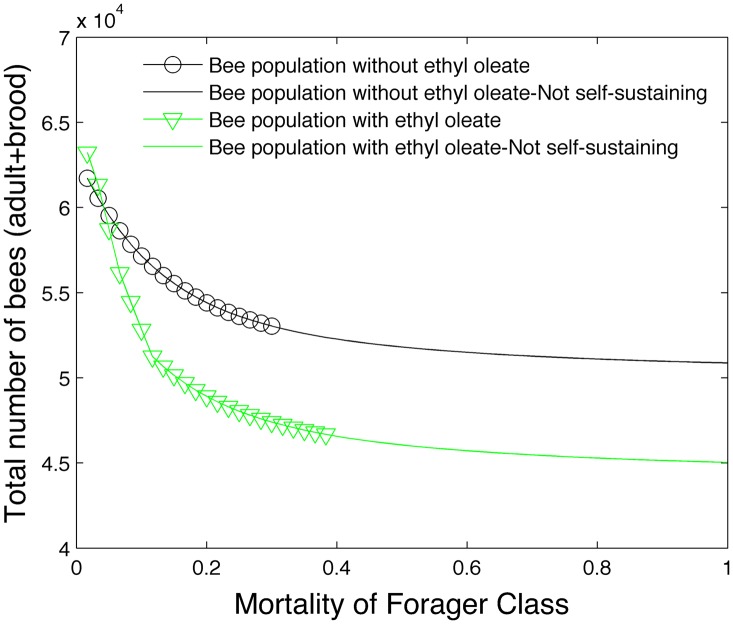
Effect of ethyl oleate on bee population.